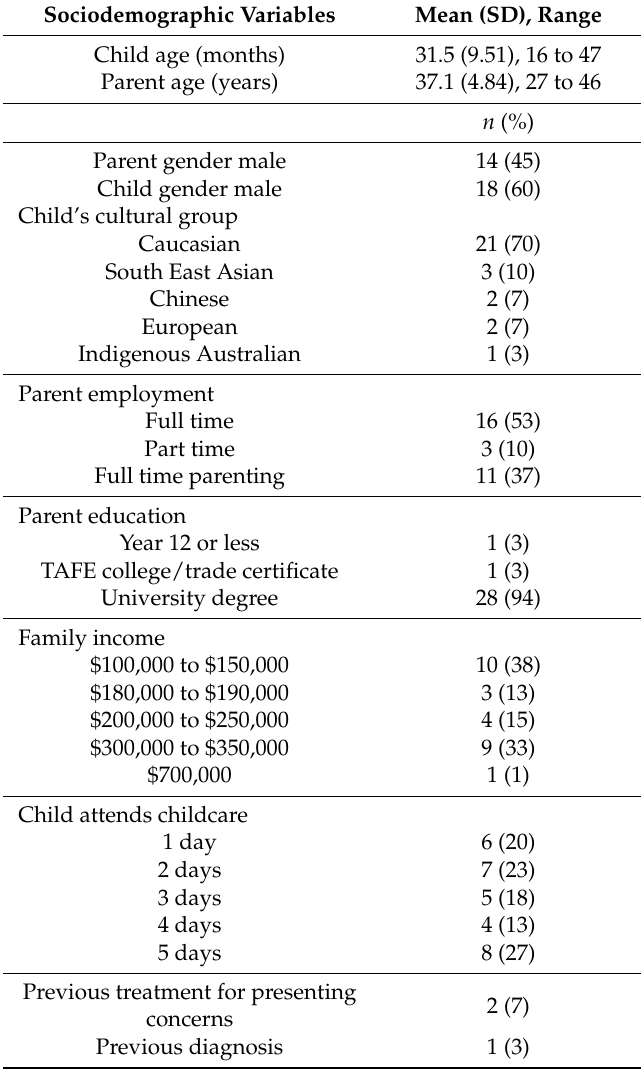
Table 1. Socio-demographic characteristics of the 31 Families who completed the